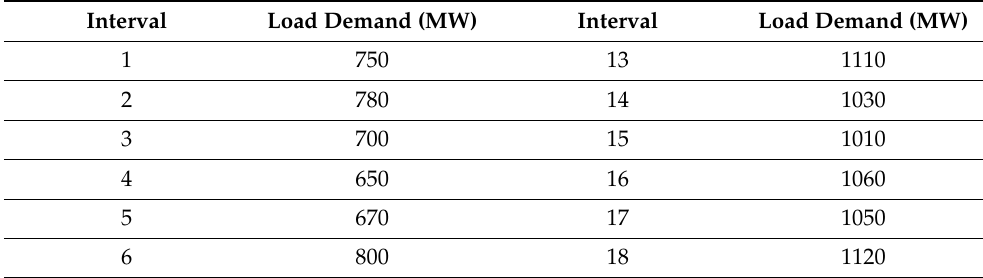
Table A4. MSHTS problem Test System-I and II load